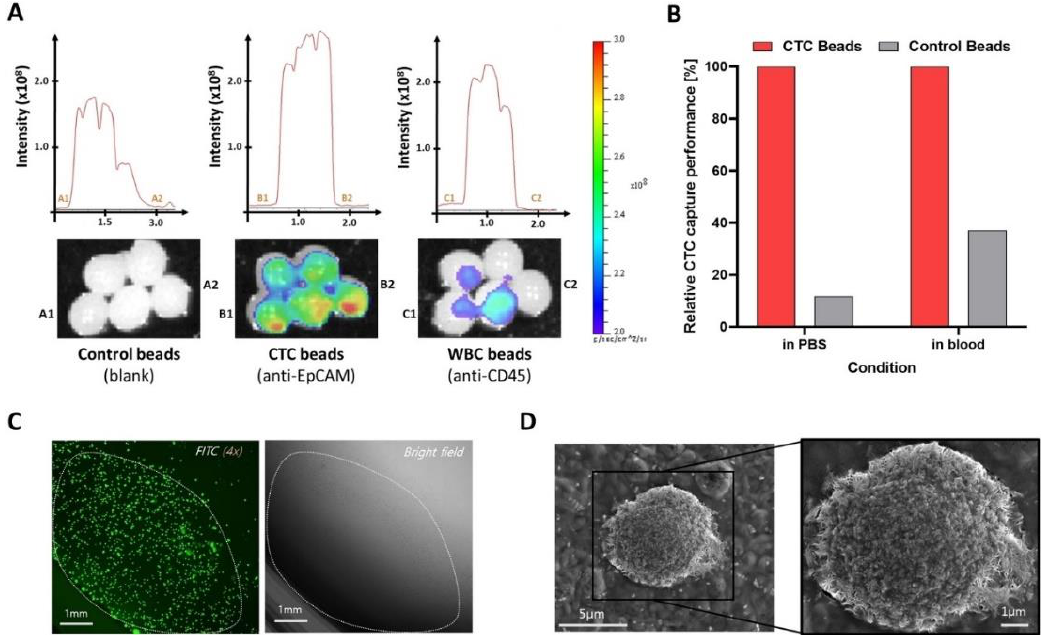
Figure 2. Performance of liquid biopsy hydrogel beads (LBBeads) for circulating tumor cell (CTC) recovery. ( A ) CTC capture performance comparison based on fluorescence intensities using fluorescent cancer cells with three different hydrogel beads; ( B ) CTC recovery performance after capture and release of cancer cells from the beads ( C , D ) Isolated fluorescent MCF-7 cancer cells under fluorescence microscope ( C ) and scanning electron microscope (SEM) ( D ). (Reprinted with permission from [31]. Copyright 2021 Wiley).